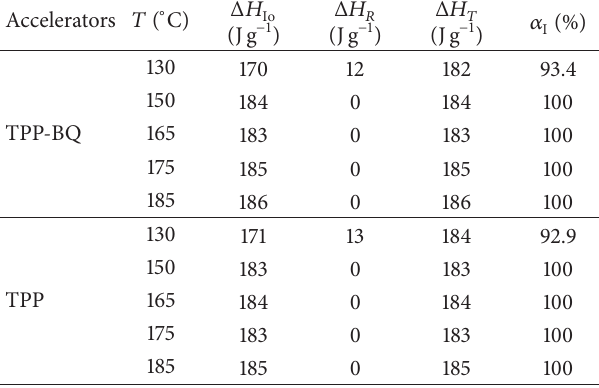
Table 2: Heats of reaction of epoxy molding compounds catalyst by TPP and TPP-BQ.